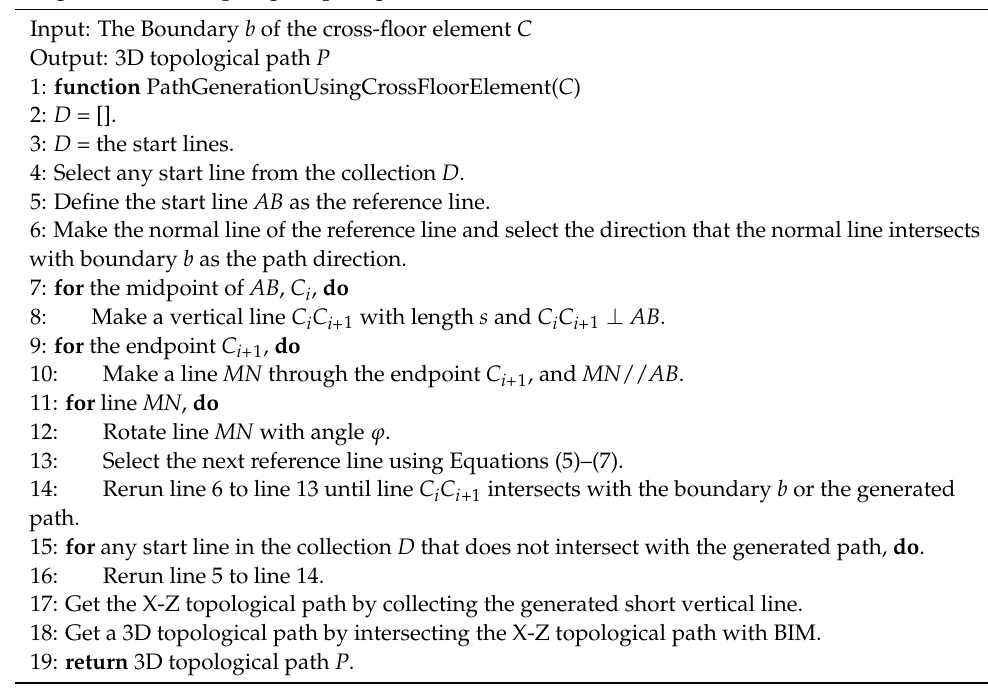
Algorithm 2. 3D topological path generation for the cross-floor